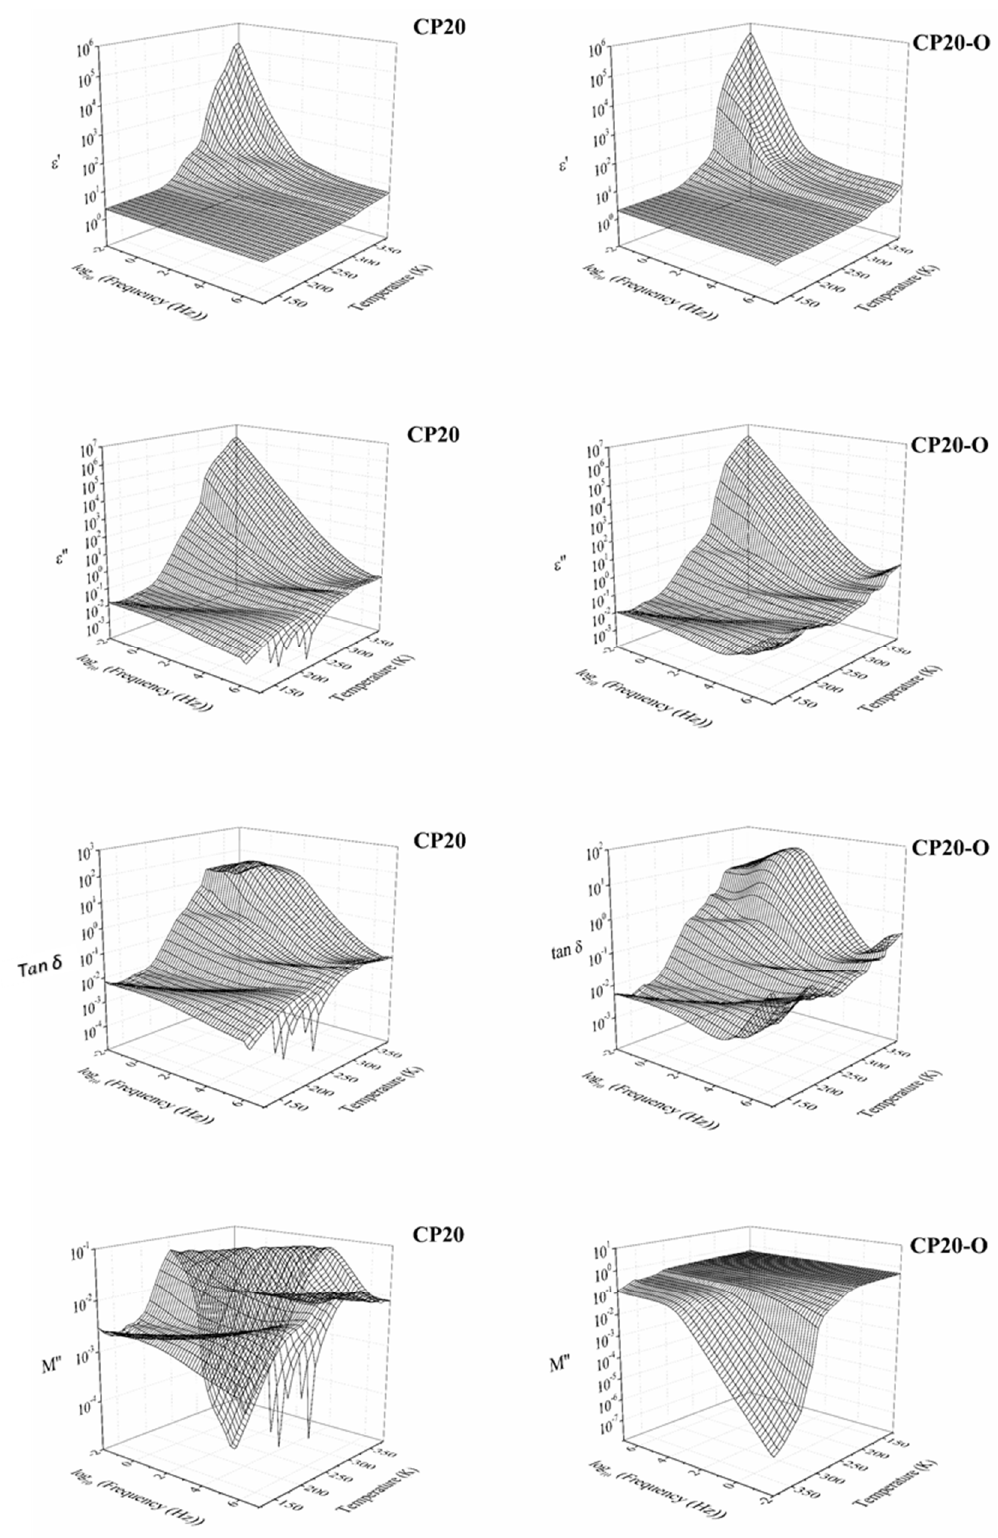
Figure 4. Three-dimensional plot of the dielectric spectra of the CP20 and CP20-O in terms of the real part of the dielectric permittivity ( ε ’ ), the imaginary part of the dielectric permittivity ( ε ” ), the loss tangent (tan δ ), and the imaginary part of the complex electric modulus ( M” ).